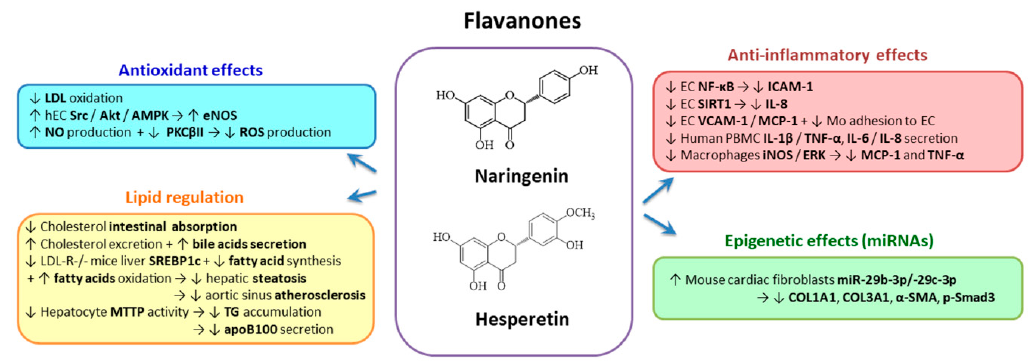
Figure 5. Chemical structure and cardioprotective mechanisms of action demonstrated by naringenin and hesperetin in experimental and clinical studies.